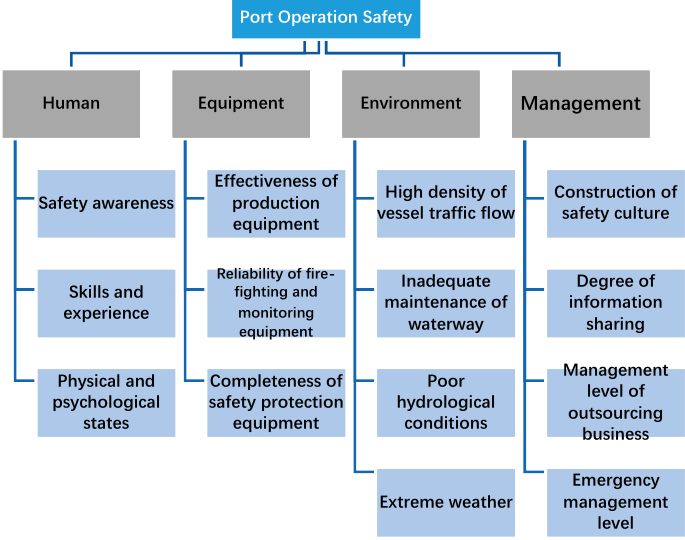
Figure 1. Hierarchical decomposition of port operation safety analysi s.